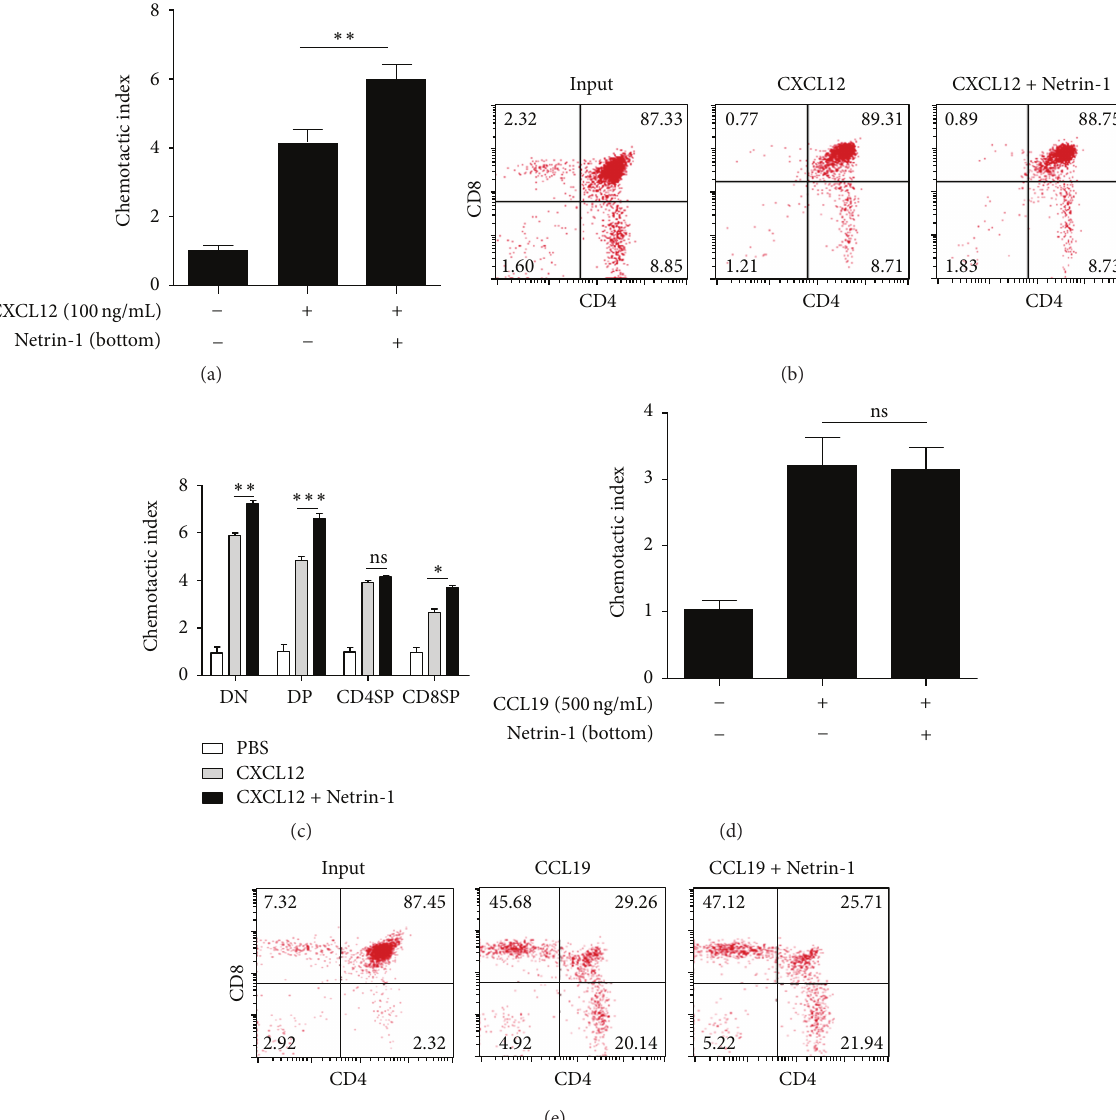
Figure 4: Netrin-1 up-regulation of CXCL12-driven mice thymocyte migration. (a) Netrin-1 partially augmented the chemoattraction of mice thymocytes induced by CXCL12 in the lower chamber. (b) Cells migrated to the bottom well from (a) were harvested and stained with anti-CD4 and anti-CD8. The numbers in the panels are % of gated populations. (c) The effect of Netrin-1 on CXCL12 could be seen in total thymocytes, as well as in DN, DP, and CD8SP subsets. (d) Netrin-1 had no effect on total thymocytes migration induced by CCL19. (e) Cells migrated to the bottom well from (d) were harvested and stained with anti-CD4 and anti-CD8. The numbers in the panels are % of gated populations. Experiments are representatives of at least three independent experiments. ns: not significant; ∗ 𝑃 < 0.05 ; ∗∗ 𝑃 < 0.01 ; ∗∗∗ 𝑃 < 0.001